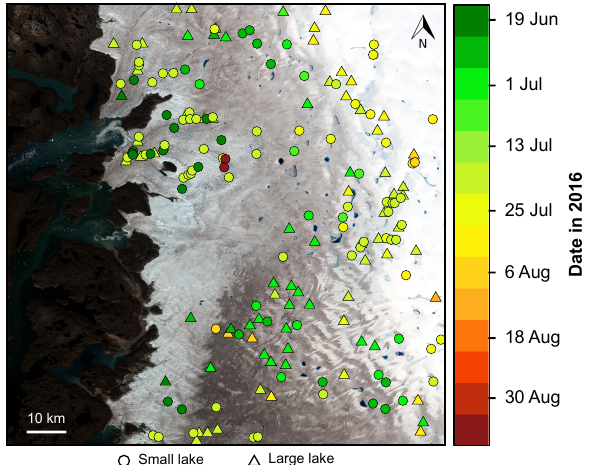
Figure 10. Frequency distribution of water volumes prior to rapid drainage for small and large lakes to show the lower and more tightly clustered water volumes contained within small lakes com- pared with large lakes. Natural logs of water volumes were taken for presentation purposes.